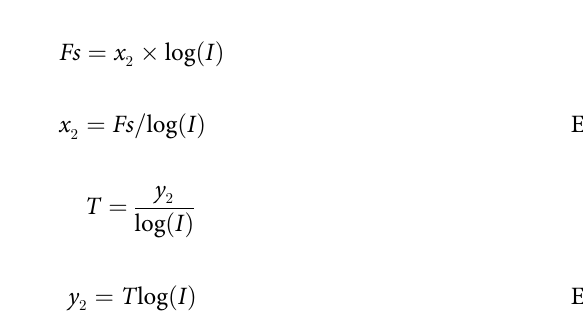
and y represent vari- 2 2